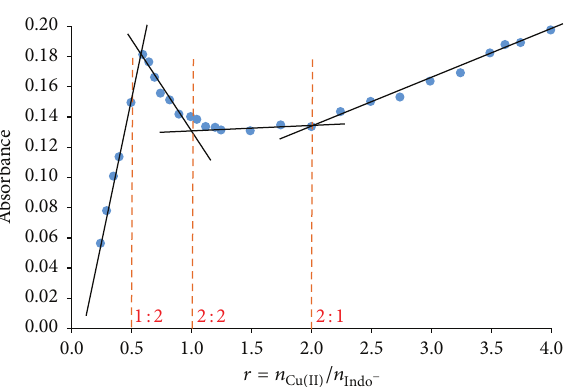
Figure 2: 𝐴 705 = 𝑓(𝑟) graph: intersections in 𝑟 = 0.5 , 1.0, and 2.0 correspond to CuIndo 2 , Cu 2 Indo 22+ , and Cu 2 Indo 3+ , respectively.